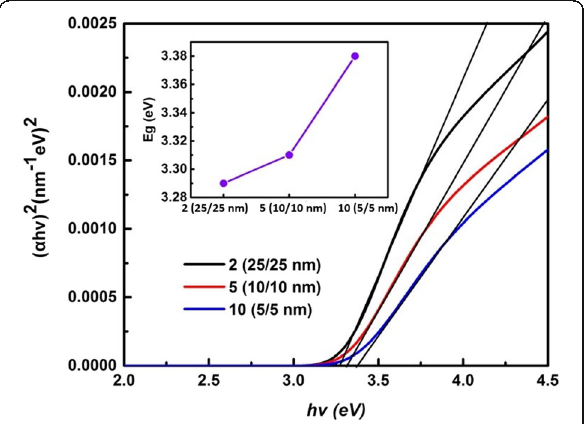
Fig. 7 Evaluated optical bandgap of nanolaminates with different bilayer